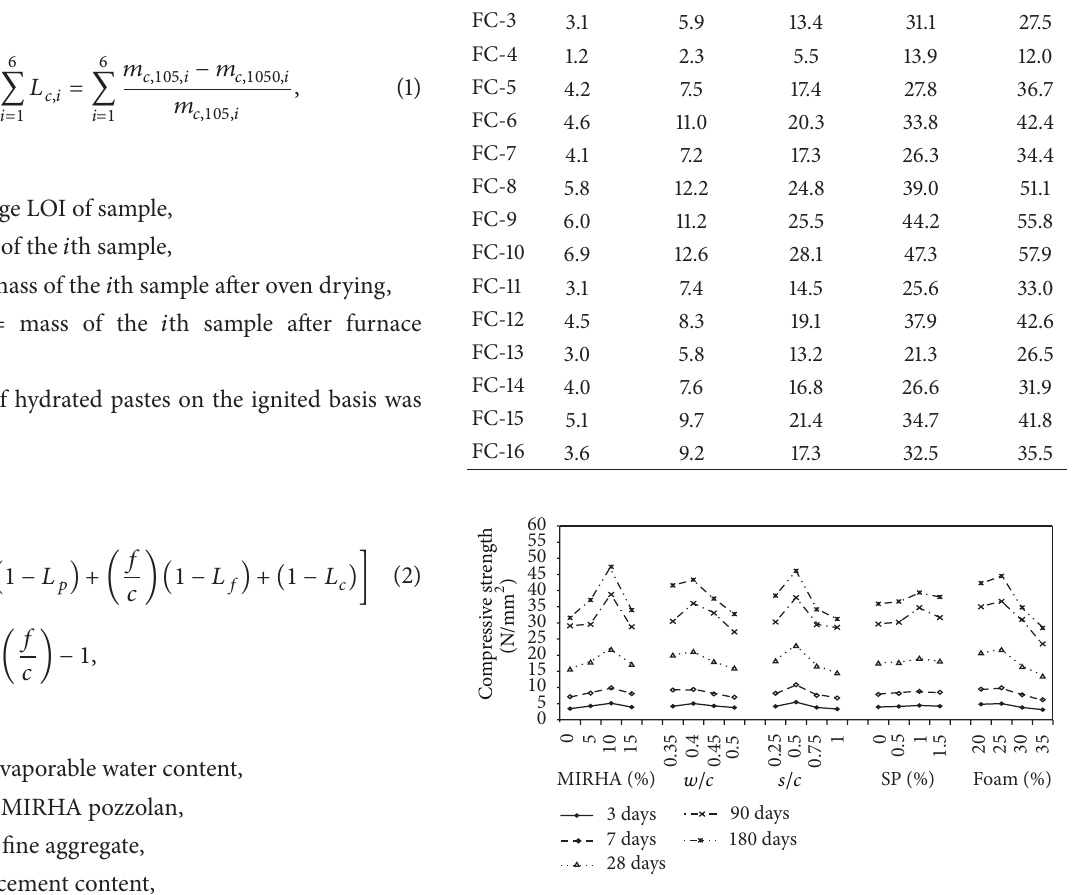
Figure 2: Summary of main effect plot for compressive